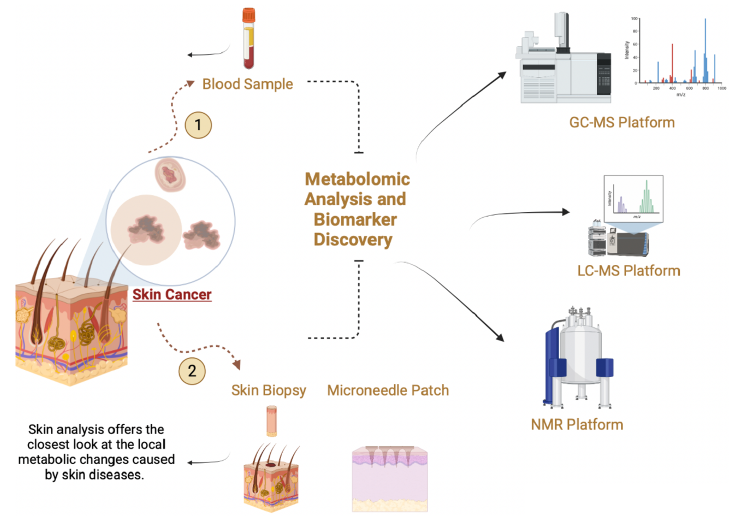
Figure 2. Correlation between Skin and Blood